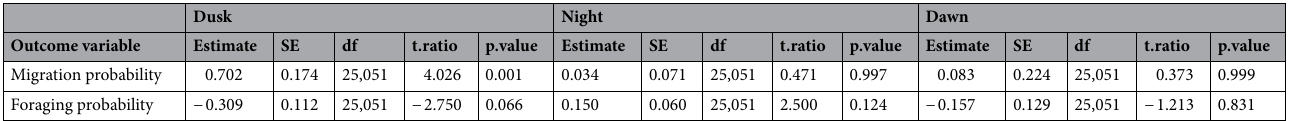
Table 1. Results of post-hoc Tukey’s comparisons between barrier and hospitable biome categories based on binomial GLMMs where the effect of biome category was tested on migration probability and foraging probability during dusk, night and dawn (n = 53,556 5-min intervals; 5 individuals). Positive estimates refer to a positive effect of the barrier biome